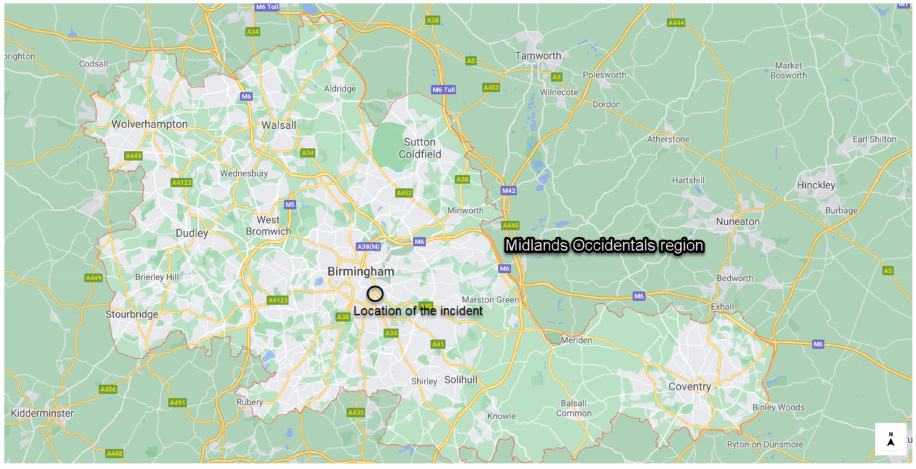
Figure 2. Location of the